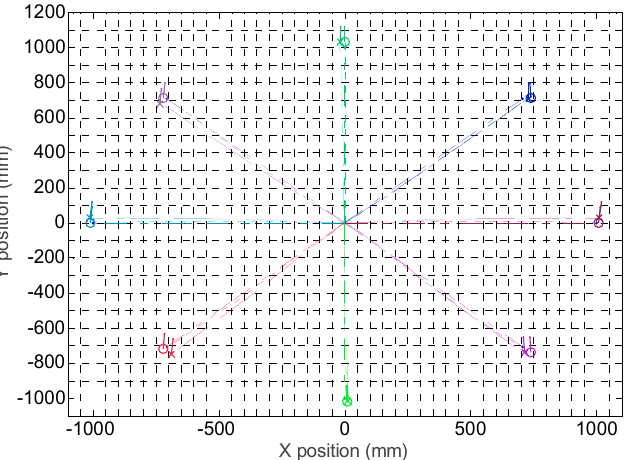
Figure 25. Trajectories followed by the mobile robot in eight displacements. The circle depicts the final position and orientation of the mobile robot obtained with the SLAM procedure. The cross depicts the final position and orientation of the mobile robot according the information of the encoders and the kinematic model.